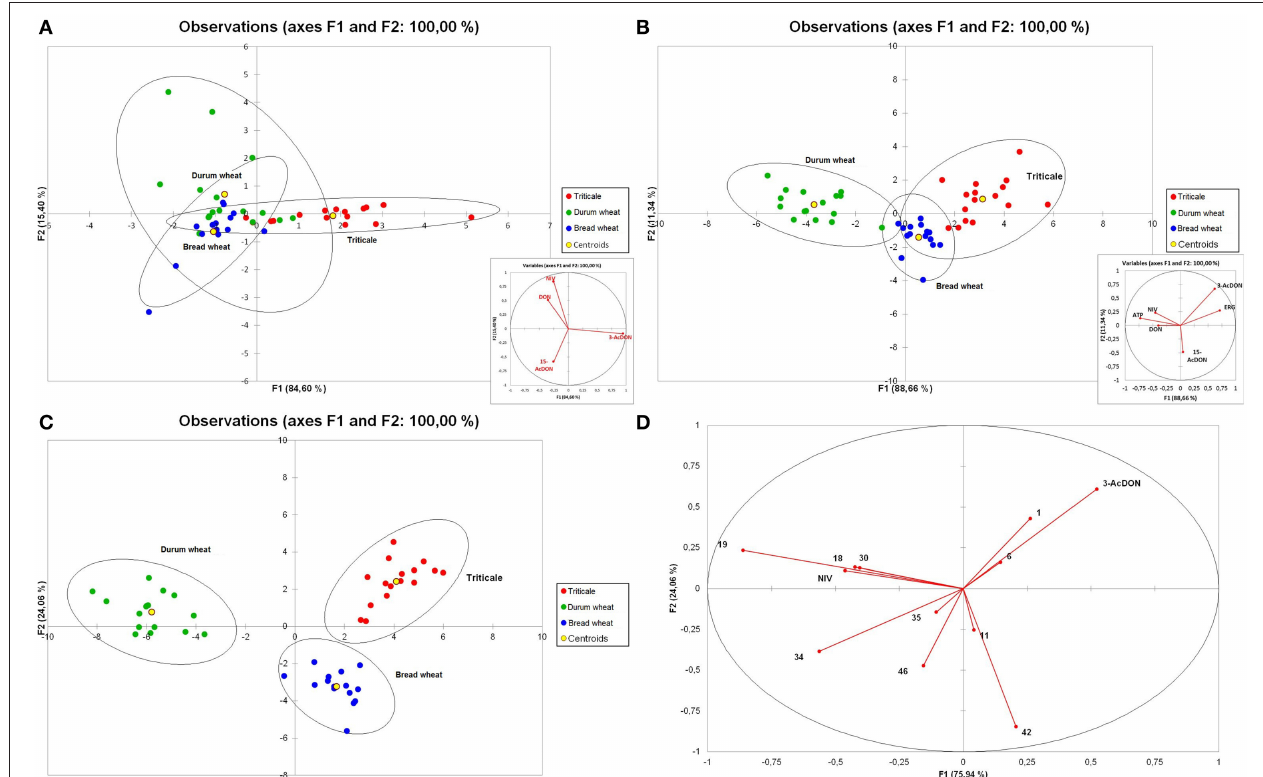
FIGURE 7 | Discriminant analysis (DA) for trichothecenes of group B—plot of observations and correlation circle for variables (A), trichothecenes and fungal biomass indicators (ERG and ATP)—plot of observations and correlation circle for variables (B) analyzed in 48 samples of cereal grain (triticale—red, durum wheat—green, and bread wheat—blue) and plot representing grain sample distribution (C) and correlation circle (D) of trichothecenes. ERG, ATP, and VOCs (numbers correspond to compound names as in Table 2 ).